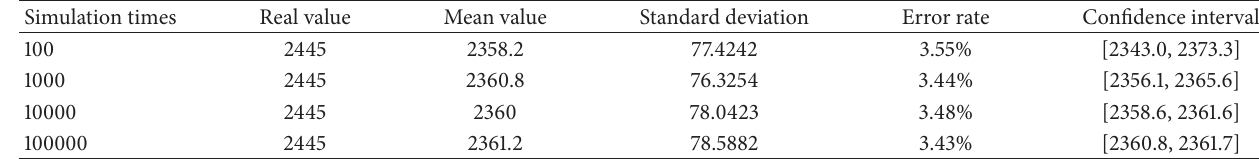
Table 2: Simulation results of SDE with FBM.